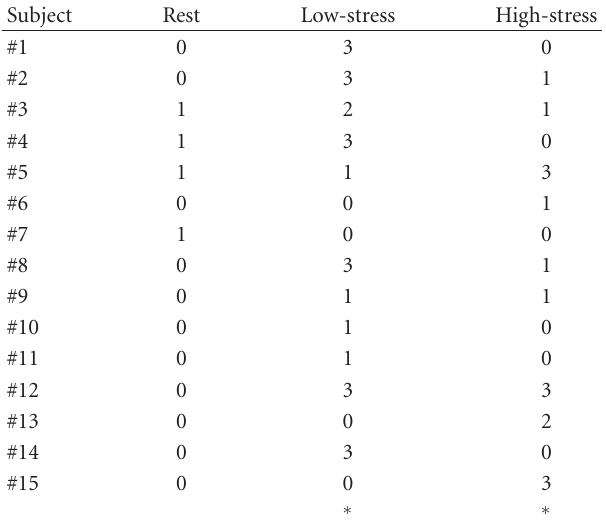
Table 1: Individual dynamics of the DNA levels of the HSV-1, VZV, and EBV in saliva of the subjects. 1, 2, 3—more than 10-fold increase in DNA levels (reactivation) of any 1, 2, or all 3 viruses in saliva; 0—no viral reactivation of any of the viruses. ∗ Statistically significant ( P < 0 . 05) di ff